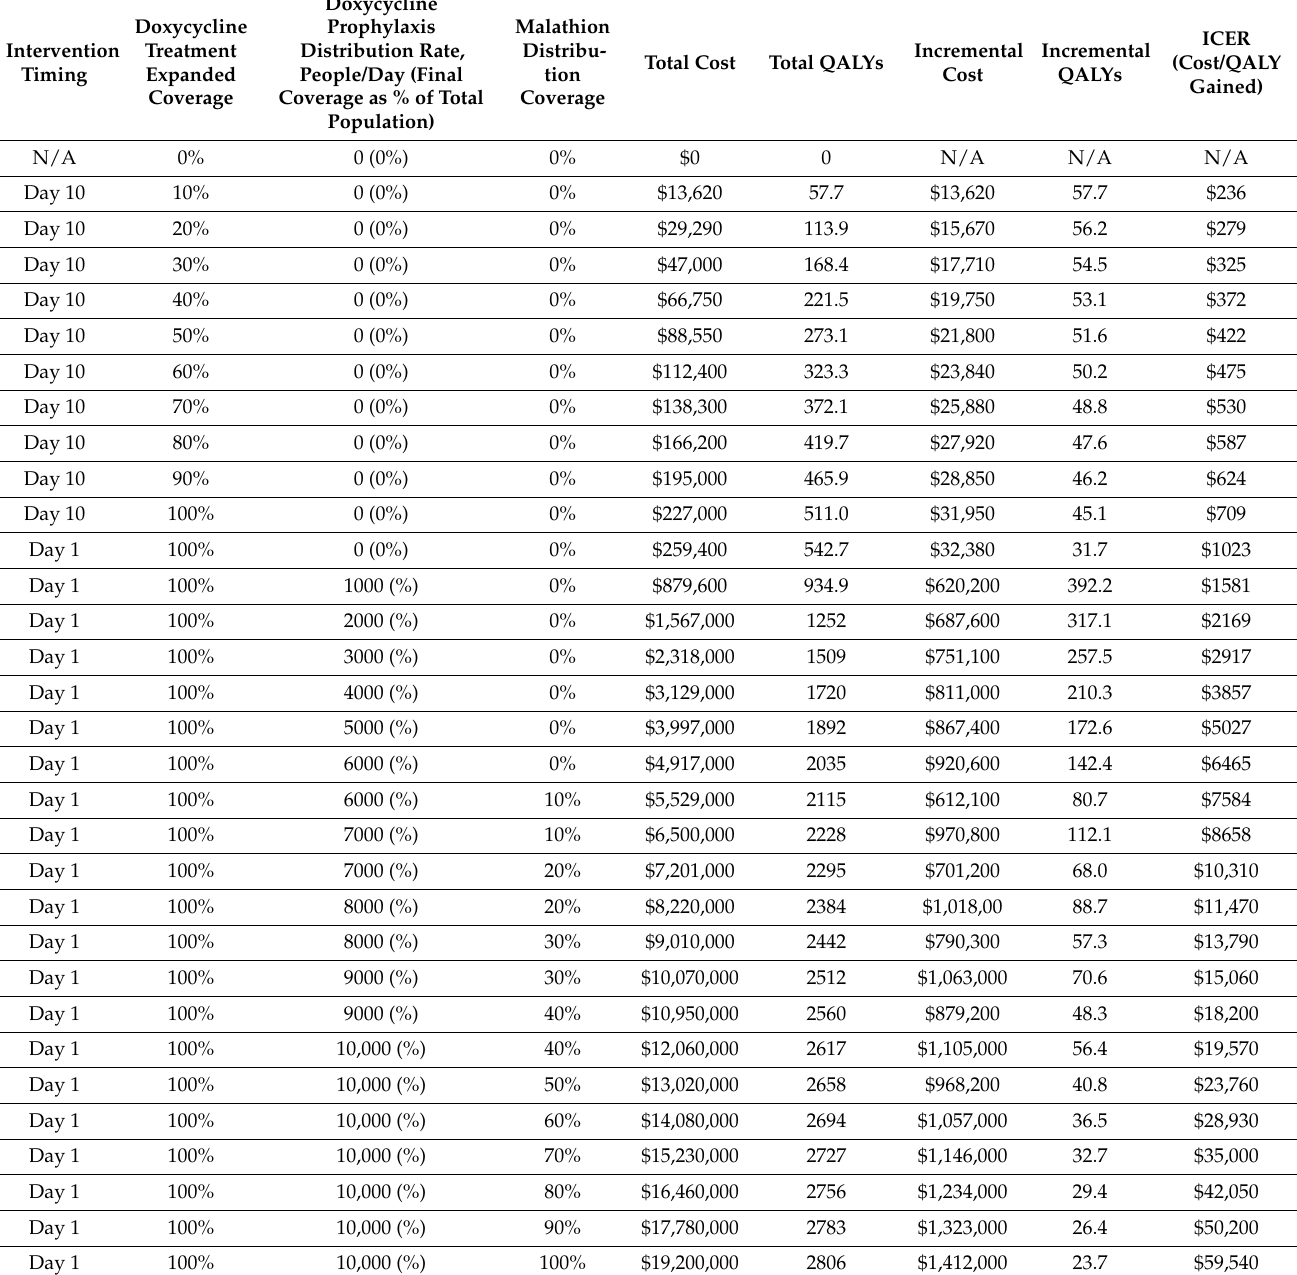
Table 3. Costs and Effectiveness of Interventions on the Cost-Effectiveness